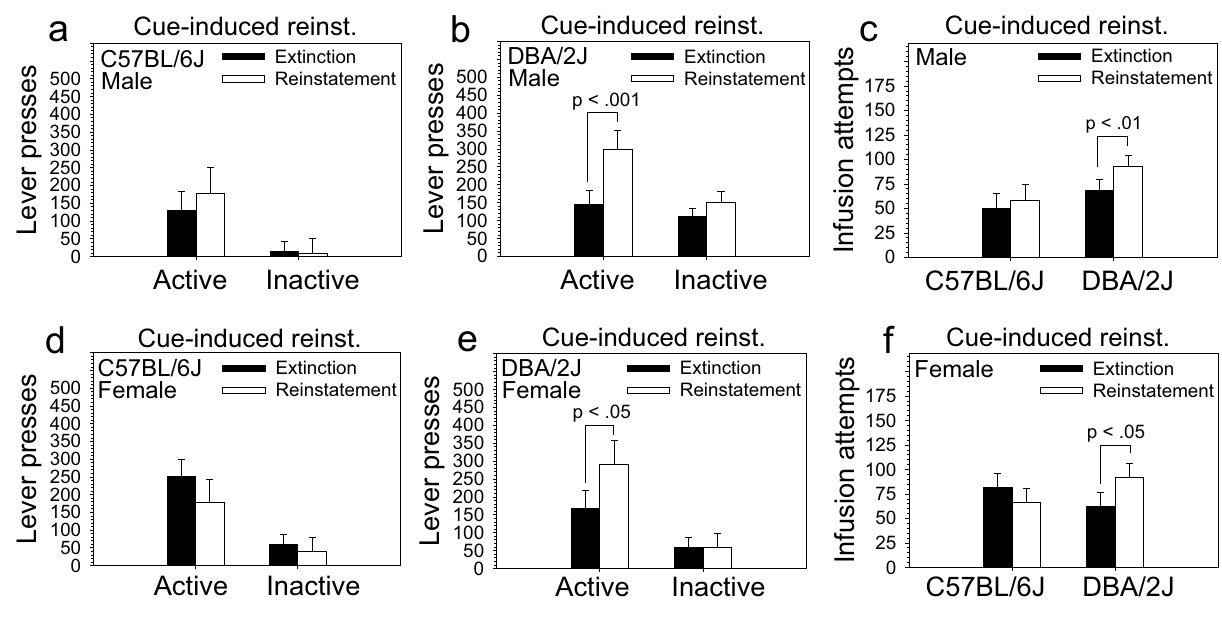
Figure 5. Cue-induced reinstatement of intravenous fentanyl self-administration in C57BL/6J and DBA/2J mice. Following the extinction stage, mice were evaluated on cue-induced reinstatement. Performance on a single reinstatement session was compared to performance on the extinction session from the prior day. ( a , b , c ) Male and ( d , e , f ) female DBA/2J mice, but not C57BL/6J mice, significantly escalated infusion attempts and active lever pressing, but not inactive lever pressing, on the cue-induced reinstatement stage. Cue-induced reinstatement was not influenced by sex. Data are presented as the mean ±